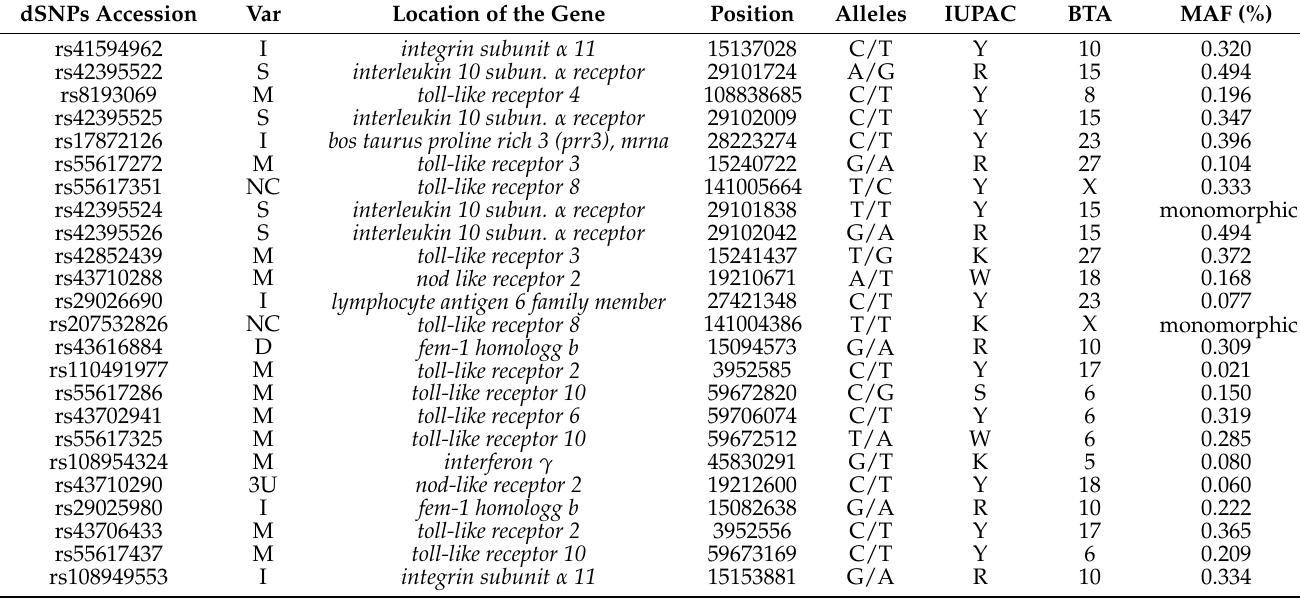
Table 1. List of SNP markers tested in Curraleiro P é -Duro